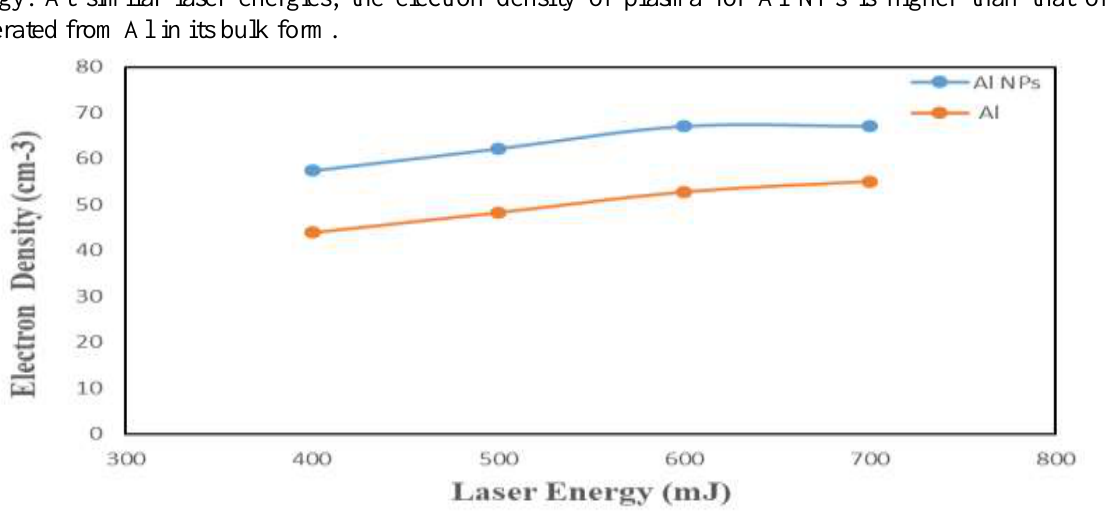
Figure 8: The electron density change with the laser energy of Al bulk and Al NPs plasma at the atmospheric